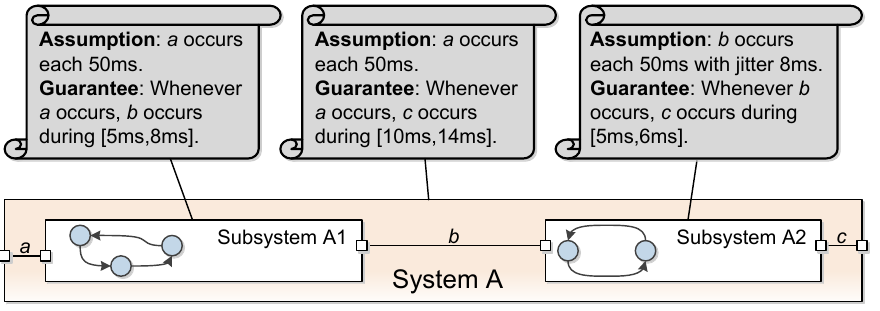
Figure 1. Example for a contract